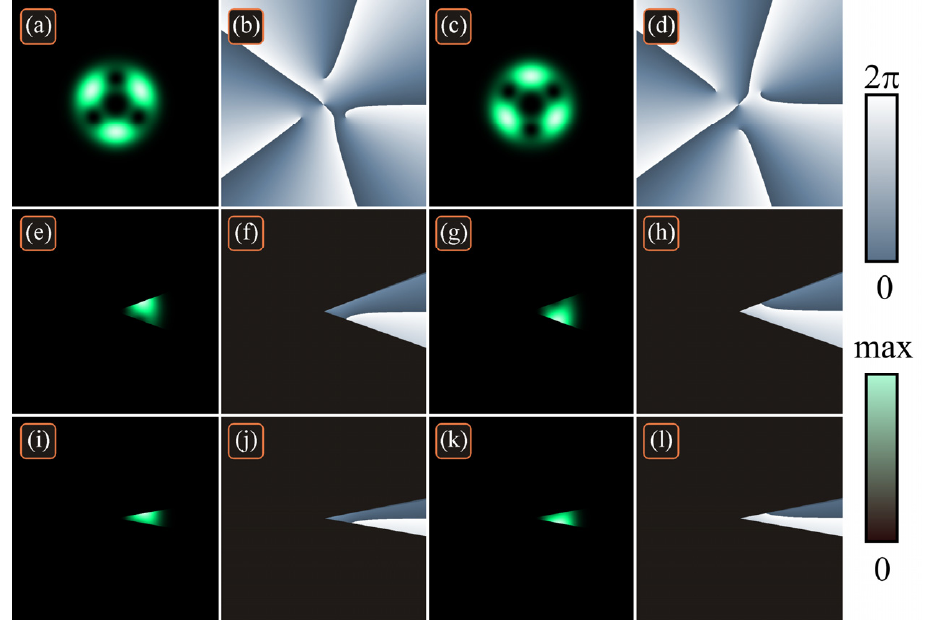
Figure 7. Intensity (1st and 3rd columns) and phase (2nd and 4th columns) distributions of two different superpositions of two single-ringed LG beams with different energies and ± π /2 phase delay between them, passing through sector apertures with different angles.